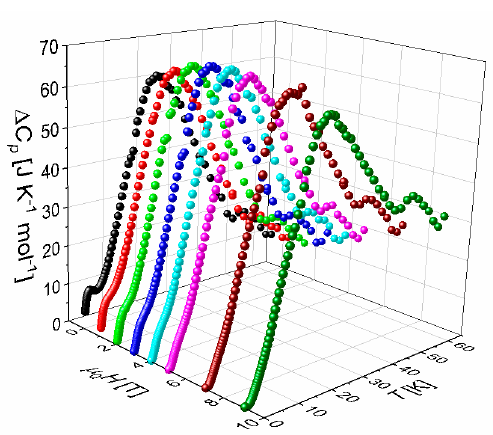
Figure 4. Temperature dependence of the magnetic excess heat capacity of 1 .